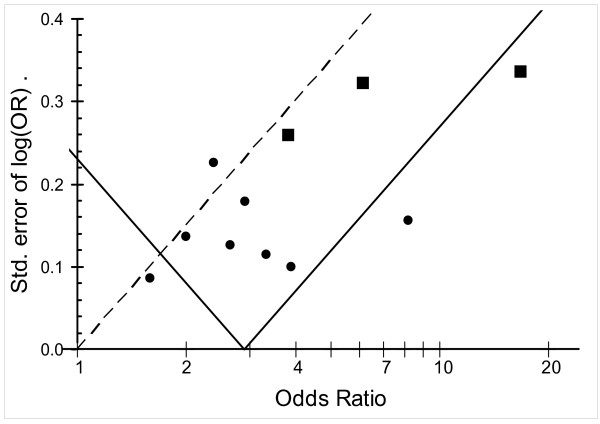
Funnel plot of the odds-ratio against the precision of the estimates. Points to the right of the dashed line are significant at the 5% level. The apex of the funnel gives the point estimate. Points outside the funnel differ from the point estimate at the 5% level and suggest heterogeneity in the estimates. If there is no bias in the selection of studies for publication, the points should be evenly scattered to the left and right. Squares represent the three studies with largest standard error that were excluded in the category "Excluding three smallest studies" in table 2 (Mori et al 1992, Spletter 2000, and Riekstina et al 2005). The two filled circles that are outside the funnel represent the two additional studies that were excluded in the category "Excluding three smallest and Brown I and Kim" in table 2